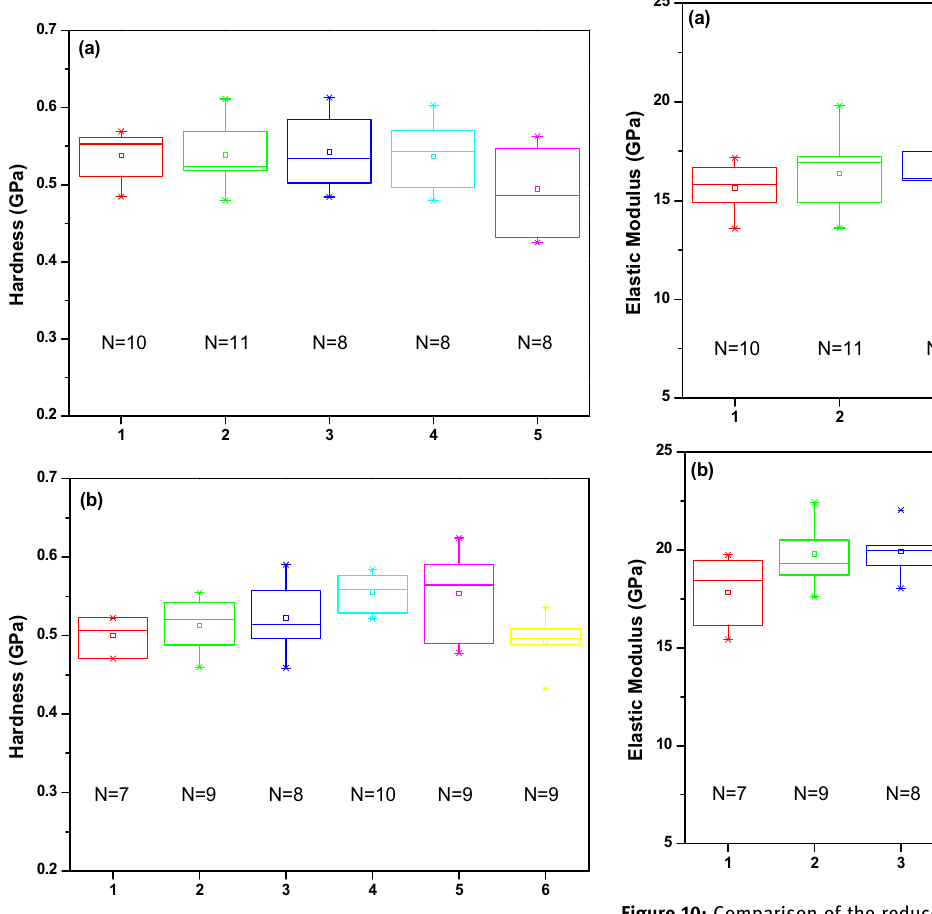
Figure 9: Comparison of the hardness in di ff erent test regions of untreated ( a ) and MAPE and Si69 treated ( b ) RubWPC.